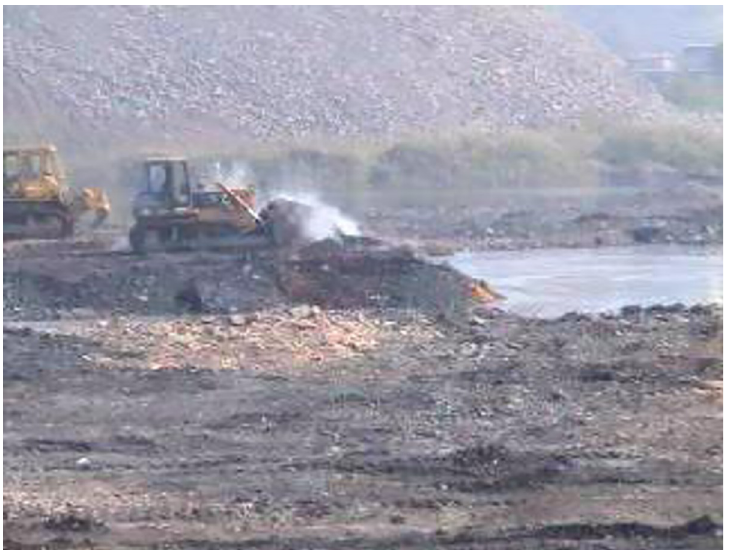
Fig 2. Bulldozer pushes coal gangue to fill